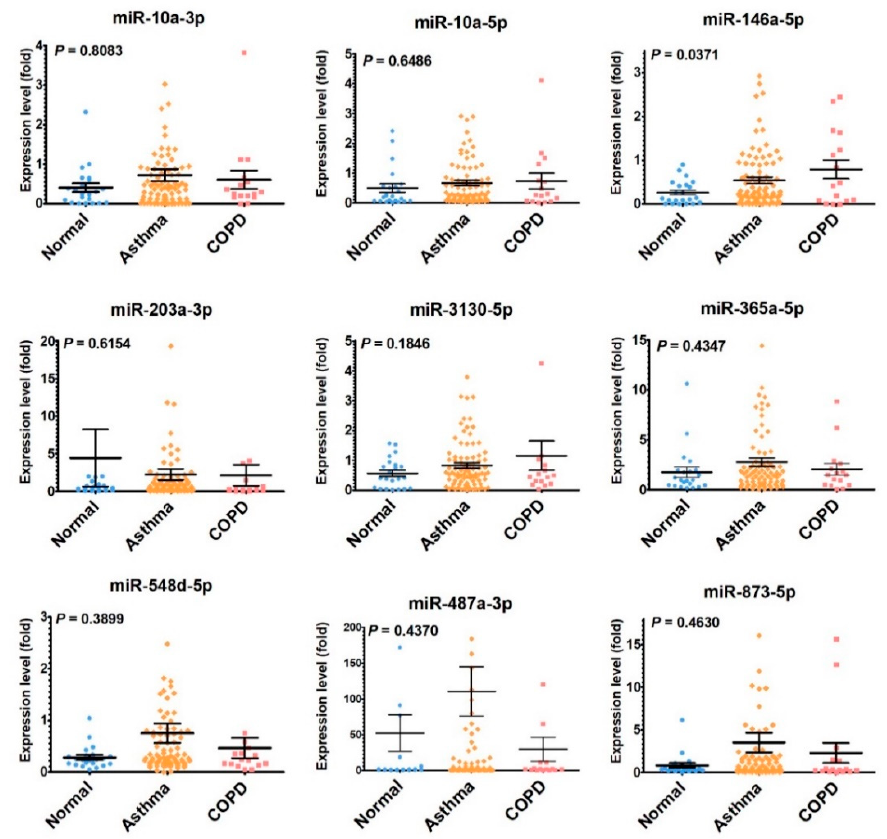
Figure 7. The serum levels of microRNAs in normal subjects, asthmatic patients, and COPD patients. The expression levels of microRNAs were assessed with qPCR. Using the 2 − ∆∆ Ct method, the relative microRNA levels were assessed. The data of subjects were plotted and the mean ± standard error of mean of the group were shown. The expression levels were compared between groups with analysis of variances. Using Dunnett’s post hoc analyses which took the levels of normal subjects as the reference, only the serum miR-146a-5p level was significantly higher in COPD group than that in the normal subjects ( p = 0.0215), while the serum miR-146a-5p level was not significantly higher in asthma group than in the normal subjects ( p = 0.1143). For other microRNAs, no significant difference was found with Dunnett’s post hoc analyses.